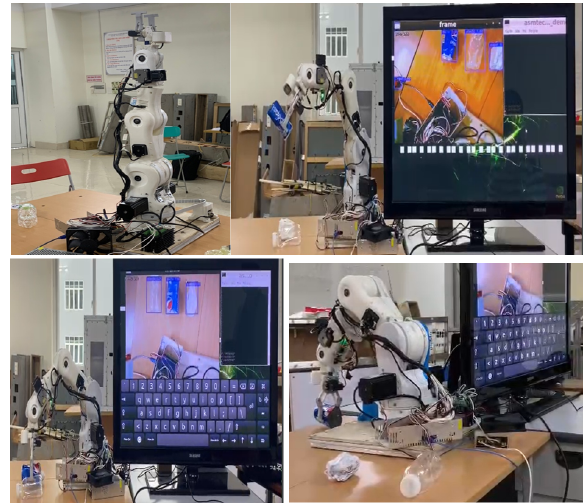
Fig. 12. Experimental results of identification and classification of